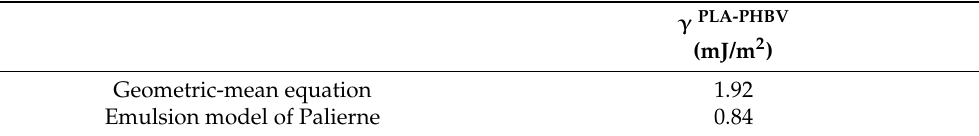
Table 8. Interfacial tension of PLA/PHBV using geometric-mean equation and Palierne’s emul- sion